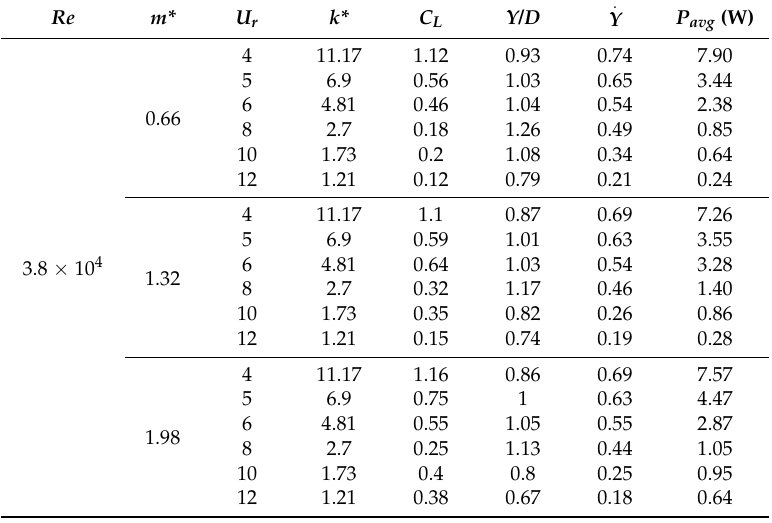
Table 5. Cylinder velocity and calculated average power for different